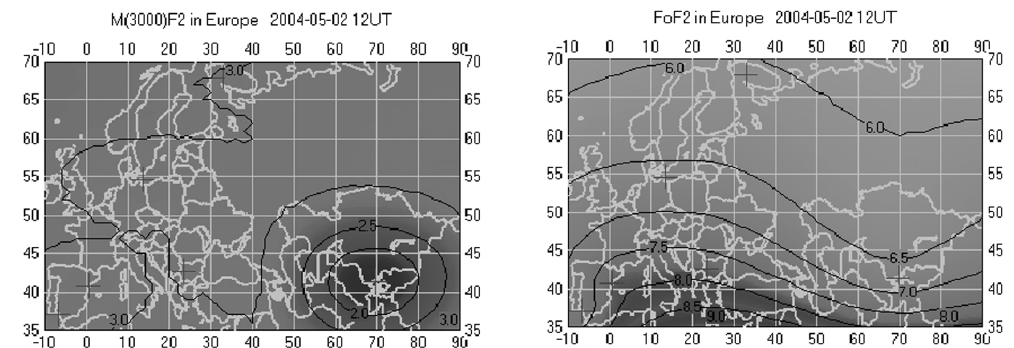
Fig. 4. Sample of foF2 and M(3000) F2 forecasted maps for European area.